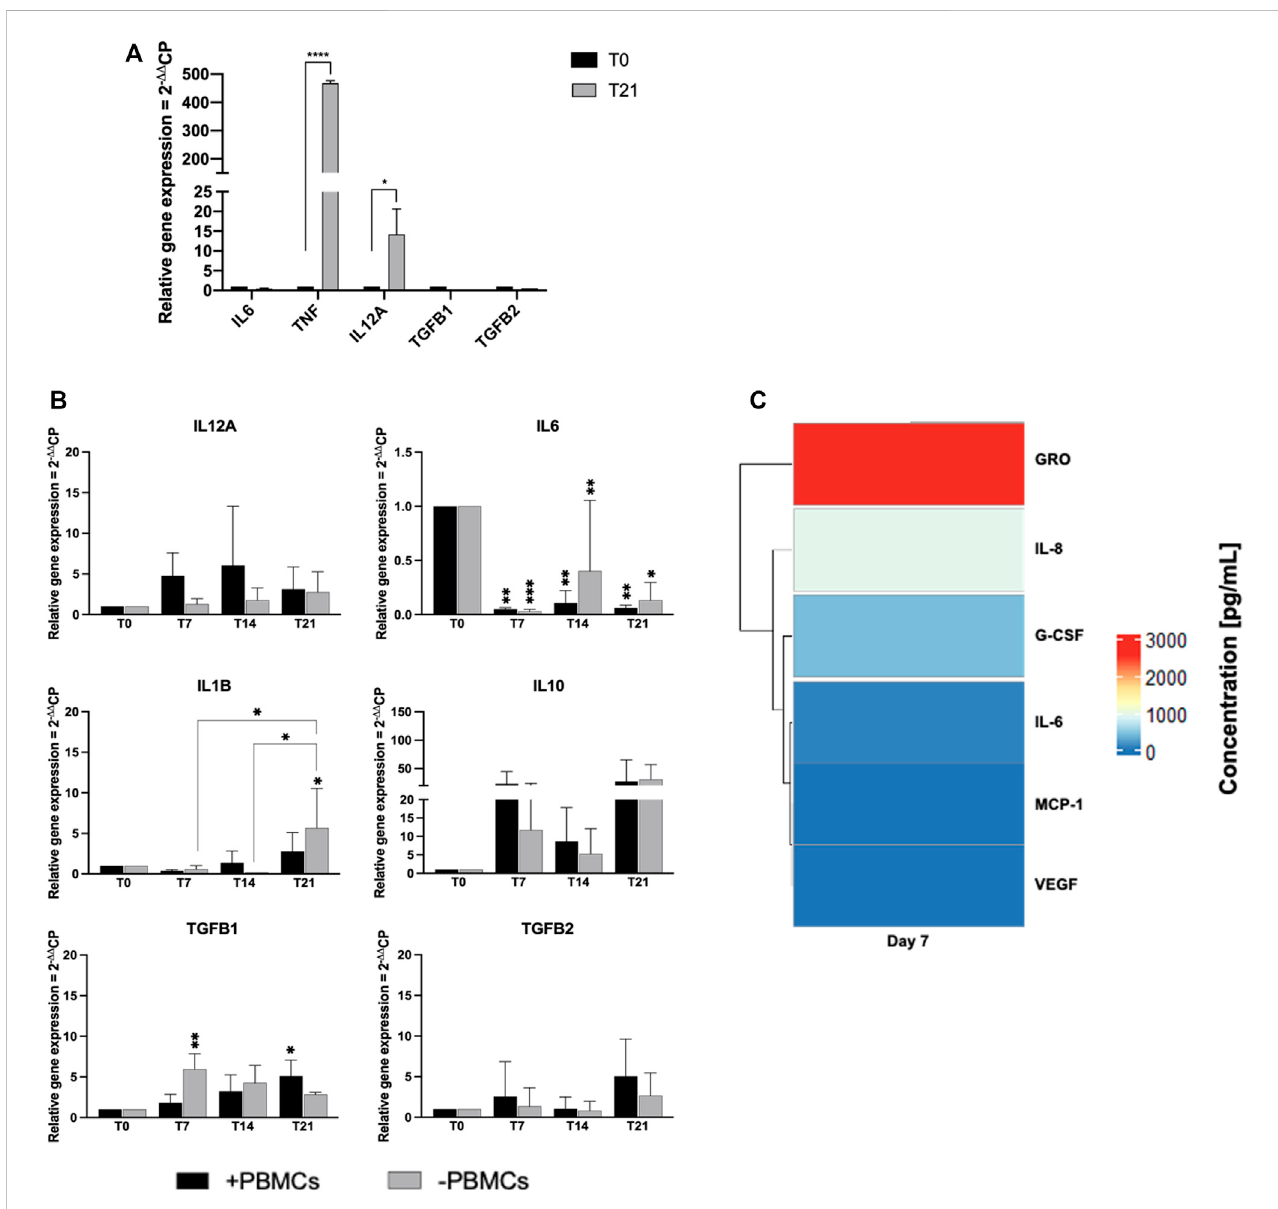
FIGURE 8 Gene expression pro fi ling for pro- and anti-in fl ammatory cytokines by quantitative RT-PCR of h SkMs (A) and of h BM-MSCs- h SkMs-PBMCs (B) , both within 3D fi brin scaffold.The mRNAlevels ofpro-in fl ammatorycytokines( IL12A , IL6 and IL1B )and anti-in fl ammatorycytokines( IL10, TGFB1 and TGFB2 )were assayed by qRT-PCR at day 7, 14 and 21 of culture. The relative quanti fi cation of each mRNA gene expression normalized to endogenous GAPDH (internal control) was calculated using the 2 − ΔΔ Ct method and presented as fold change over h SkMs at day 0 (A) and over h BM-MSCs at day 0 (B) , selected as a control.Cytokinelevelsmeasuredinculturemediumsupernatantsatday7,14,and21bymagneticbead-basedmultipleximmunoassay (C) .Dataarereported as heatmap from blue (lowest value, 0 pg/ml of concentration) to red (highest value). Cytokines were hierarchical clustered based on expression